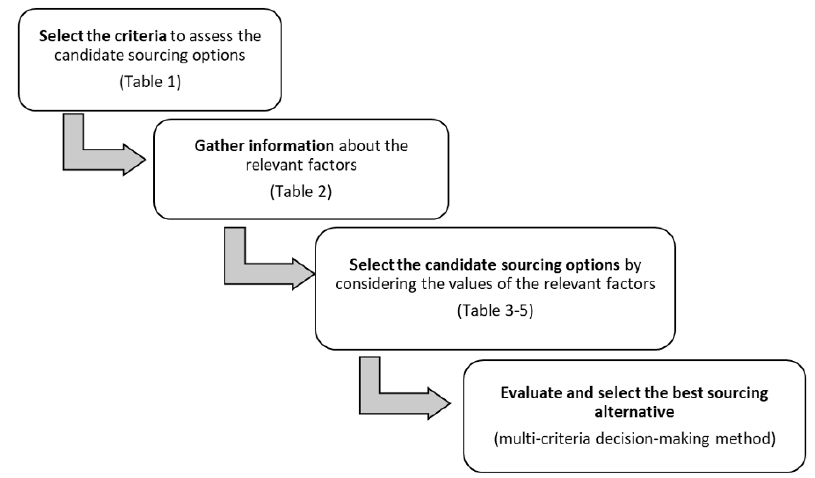
Figure 2. Flowchart of the process for choosing a strategic sourcing